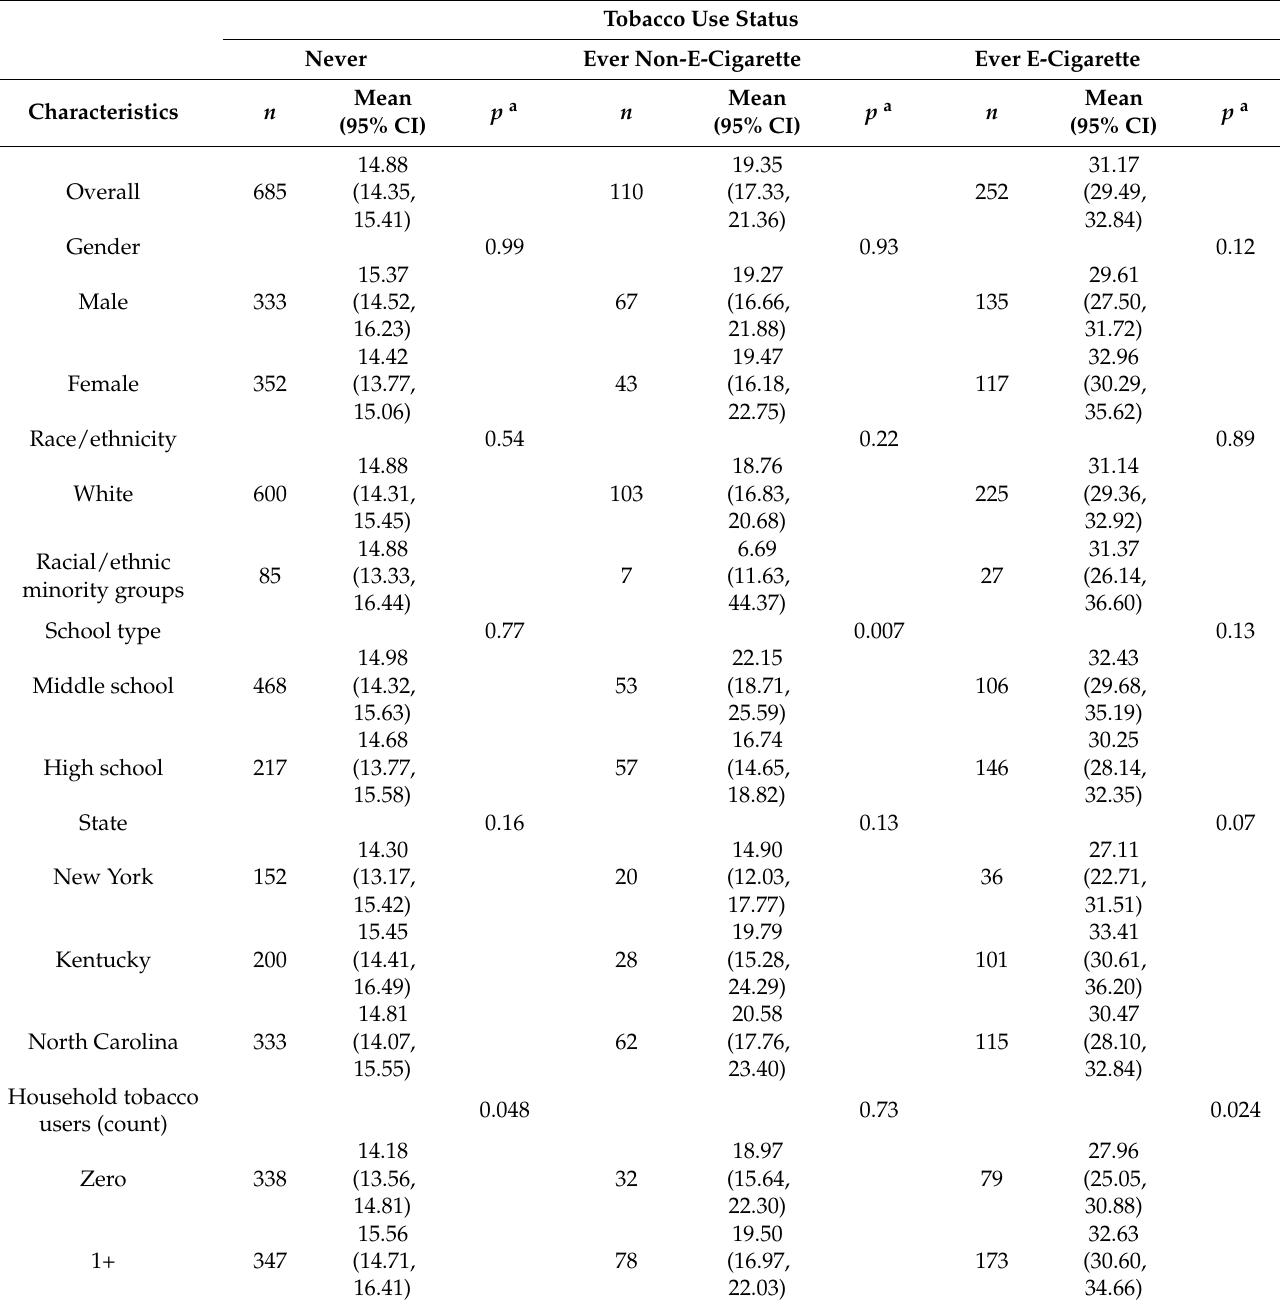
Table 3. Distribution of the E-cigarette Use Temptation Scale Within Each Tobacco Use Group by Sociodemographic